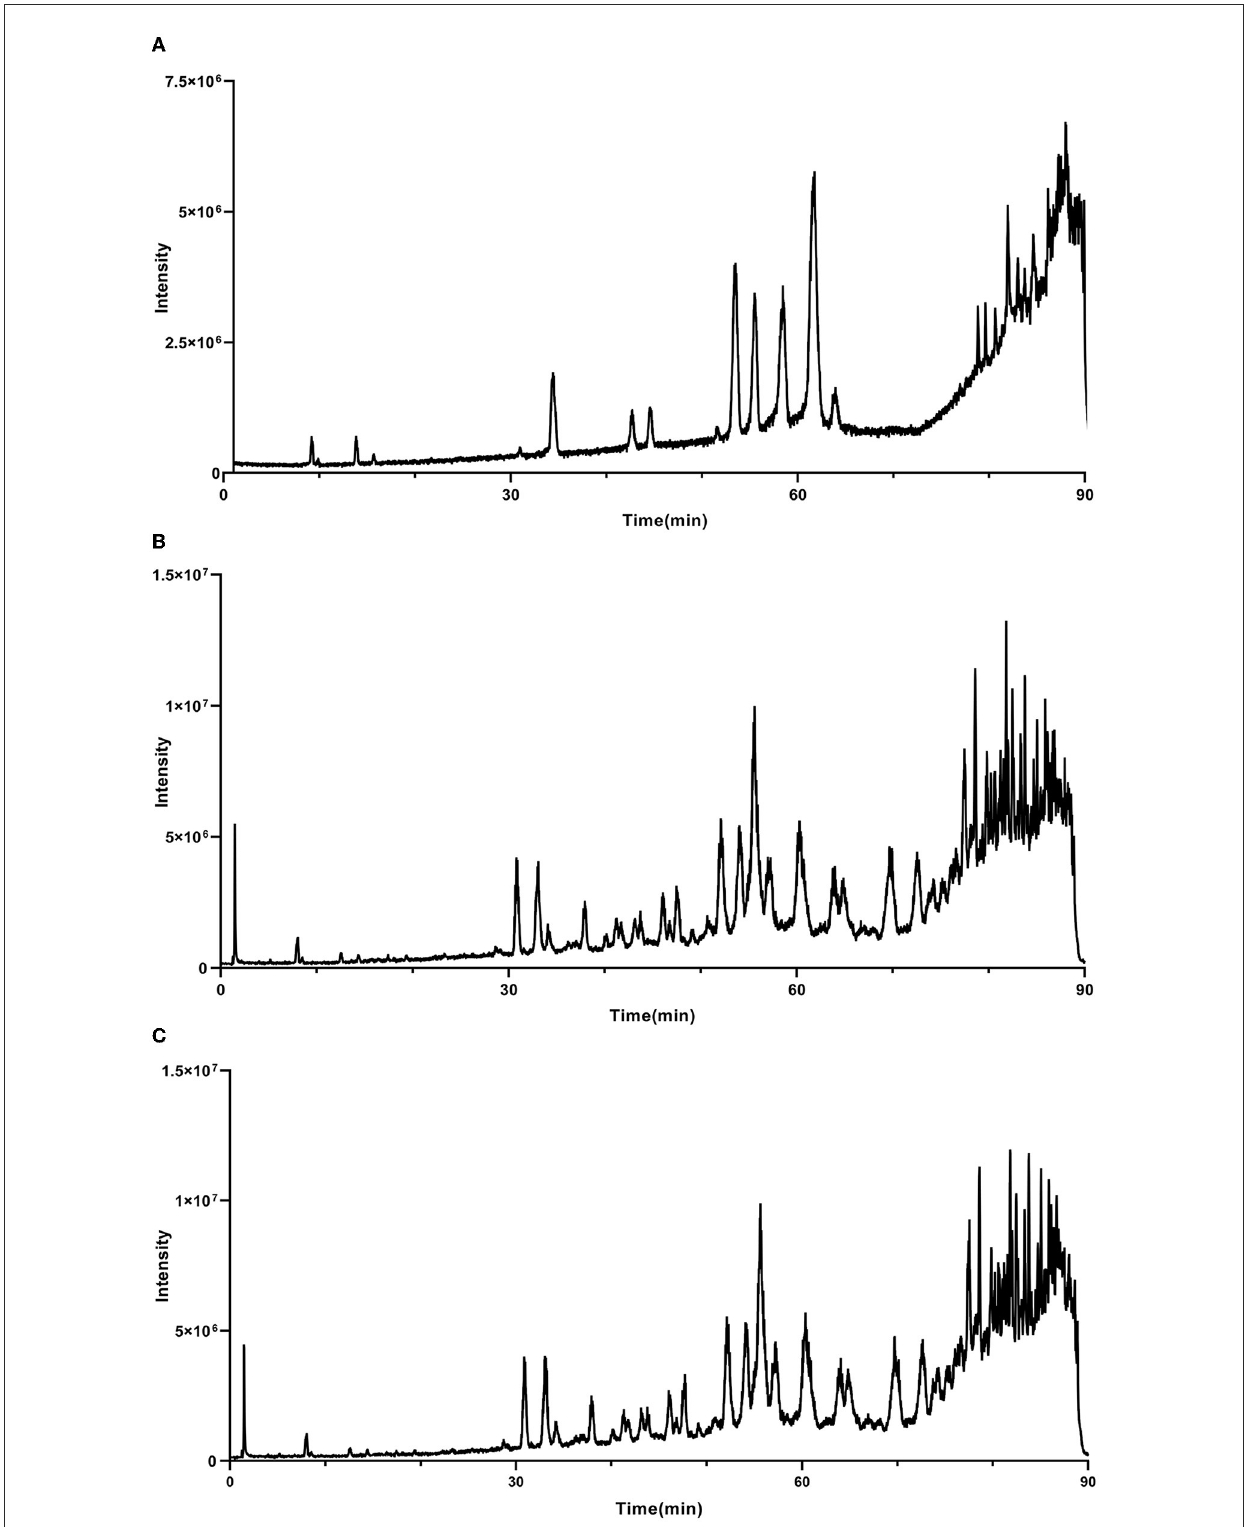
FIGURE5 Total ion chromatogram of maceration extract and ultrasound extract. (A) Standard; (B) maceration extract; (C) ultrasound extract.